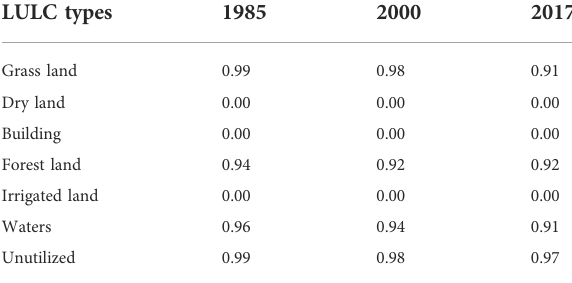
TABLE 6 Average habitat quality of different LULC types.